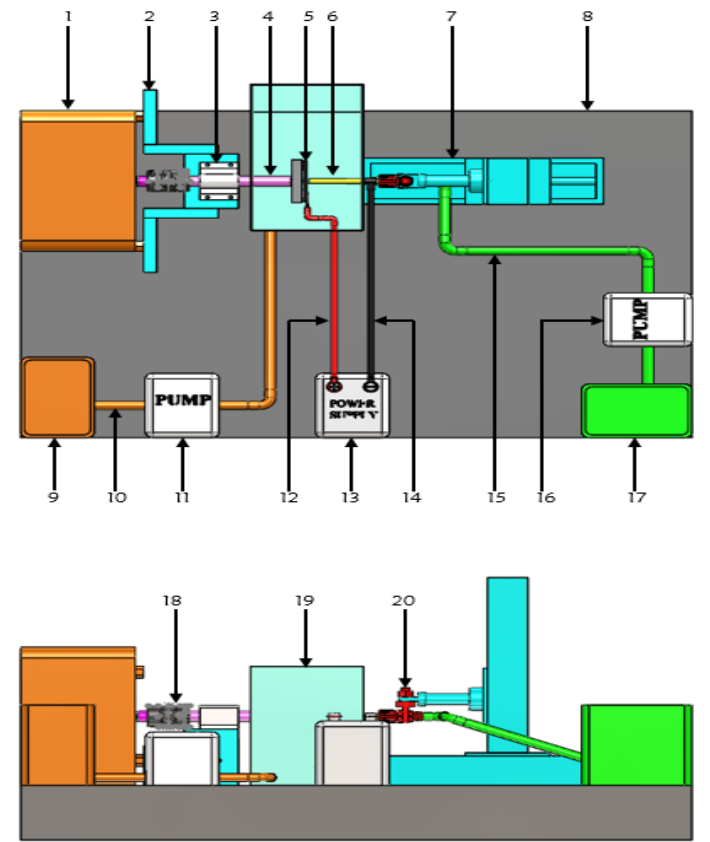
Figure 1: Front and top views of the laboratory ECM system Table 3: Physical and mechanical properties of 1018